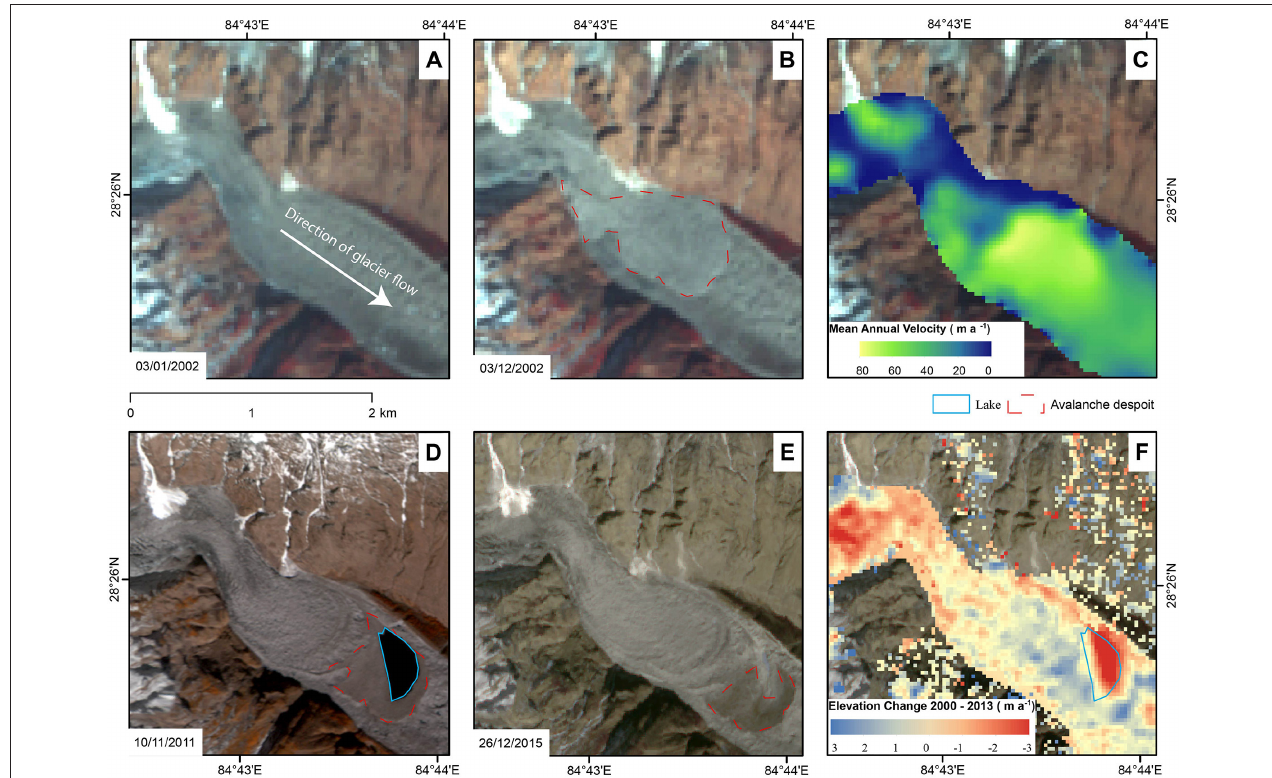
FIGURE 11 | A large rockfall hit Himal Chuli Glacier in 2002 (visible on B ). The rockfall deposit has since been transported downglacier. The surface velocity increases as the glacier flows out of the bend (C) . The glacier is flowing toward the south-east. A large lake formed in 2011 (D) which drained the following year € . Nevertheless, the location of the lake correlates with an area of increased elevation loss (F) . The satellite imagery in (D) is RapidEye imagery, (E) is Sentinel 2, the remaining satellite images are Landsat